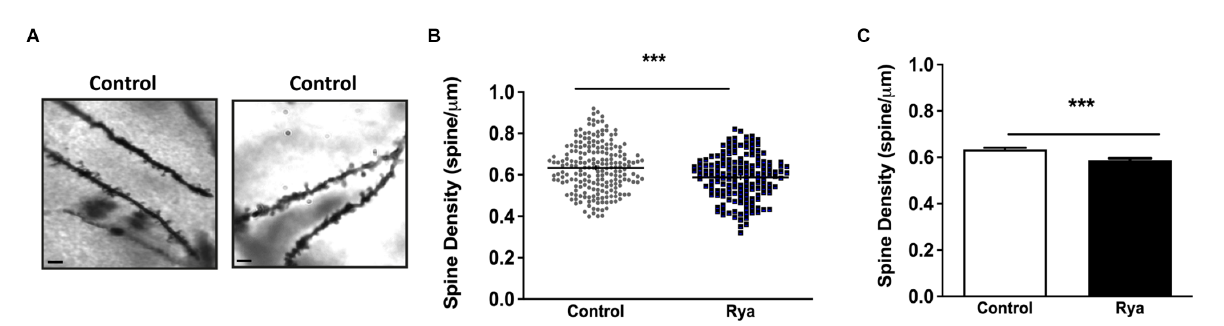
FIGURE5 Inhibitory Ryanodine decreased dendritic spine density in the hippocampal CA1 region. (A) Representative images of neurites from the CA1 region of rat hippocampal slices stained with FD rapid Golgi Stain. Scale Bar: 2 µ m. (B) Spine density analysis was performed by calculating the ratio between the number of spines and the dendritic length (in µ m). Spine density values displayed by neurites in control slices (circles; N = 79 slices, 211 neurites) or neurites in slices incubated for 1 h with 20 µ M ryanodine (squares; N = 71 slices, 160 neurites). A total of 7,775 spines were counted in this study. Horizontal bars represent the mean values in each case. (C) Spine density values displayed by control slices or by slices preincubated for 1 h with 20 µ M ryanodine. Statistical analysis was performed by Student’s paired t -test, *** p < 0.001 ( N = 5 animals).